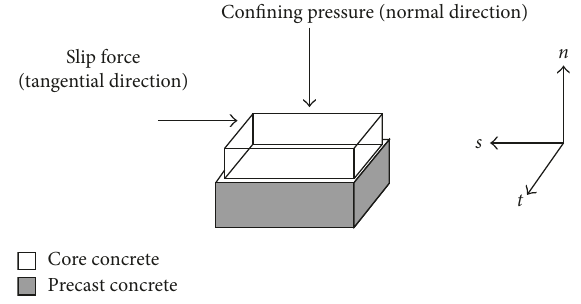
Figure 11: Description of normal and tangential